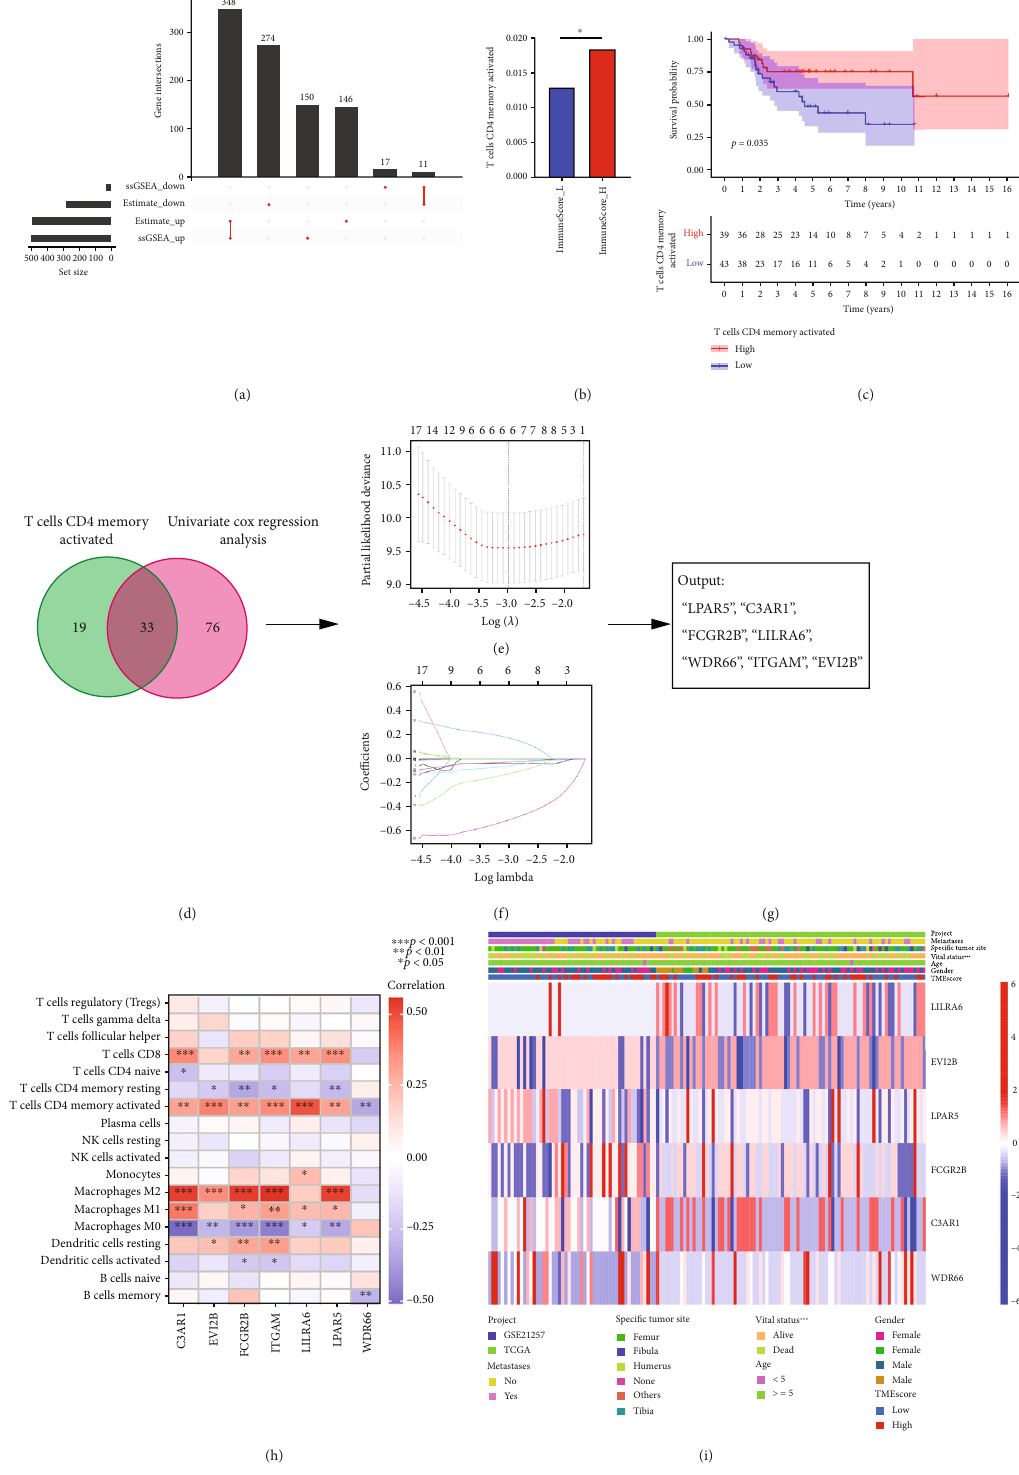
Figure 4: Construction of the TMEscore gene signature. (a) The UpSet plot compared high- and low-expression groups as determined using ESTIMATE and ssGSEA and identi fi ed 359 interaction genes. (b) CD4+ TMA was di ff erentially expressed in the high versus low immune score groups. (c) CD4+ TMA a ff ects prognosis. (d – g) Venn plots showing the number of interaction genes that are closely related to CD4+ TMA and univariate Cox regression analysis. These genes were subjected to LASSO analysis. X -axis: -log (lambda), Y -axis: LASSO coe ffi cients. LASSO analysis identi fi ed 7 genes which were subjected to follow-up analyses. (h) Analysis of correlation between the 7 genes and immune cells. (i) Heatmap visualization of the relationship between the 7 genes and clinical